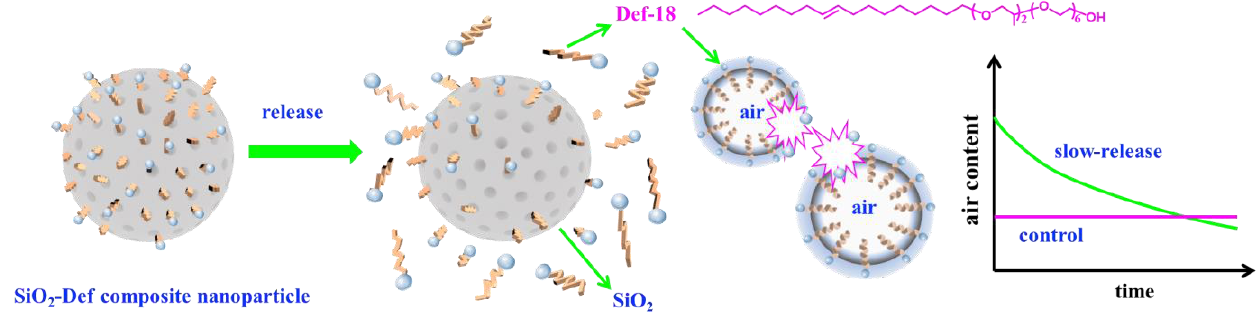
Figure 1. Illustration of the slow-release process of SiO 2 -Def.